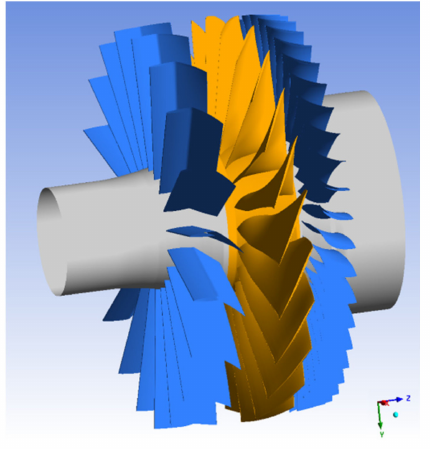
Figure 4. Model of the multistage compressor.